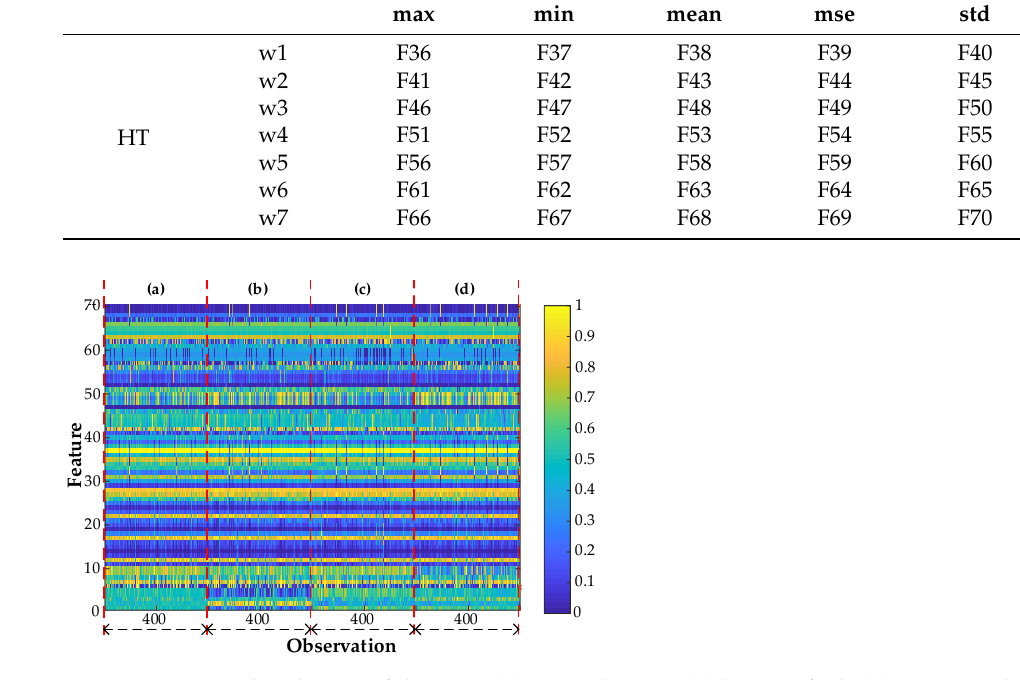
Figure 8. Feature distribution of the HHT. ( a ) Normal motor, ( b ) bearing fault, ( c ) interturn short circuit, ( d ) broken rotor bar.